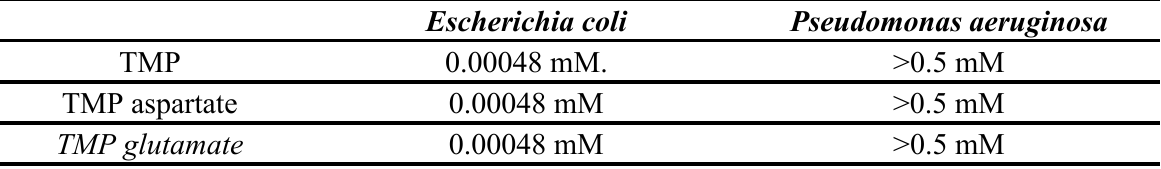
Table 4. MICs of TMP and its prepared salts against Escherichia coli and Pseudomonas